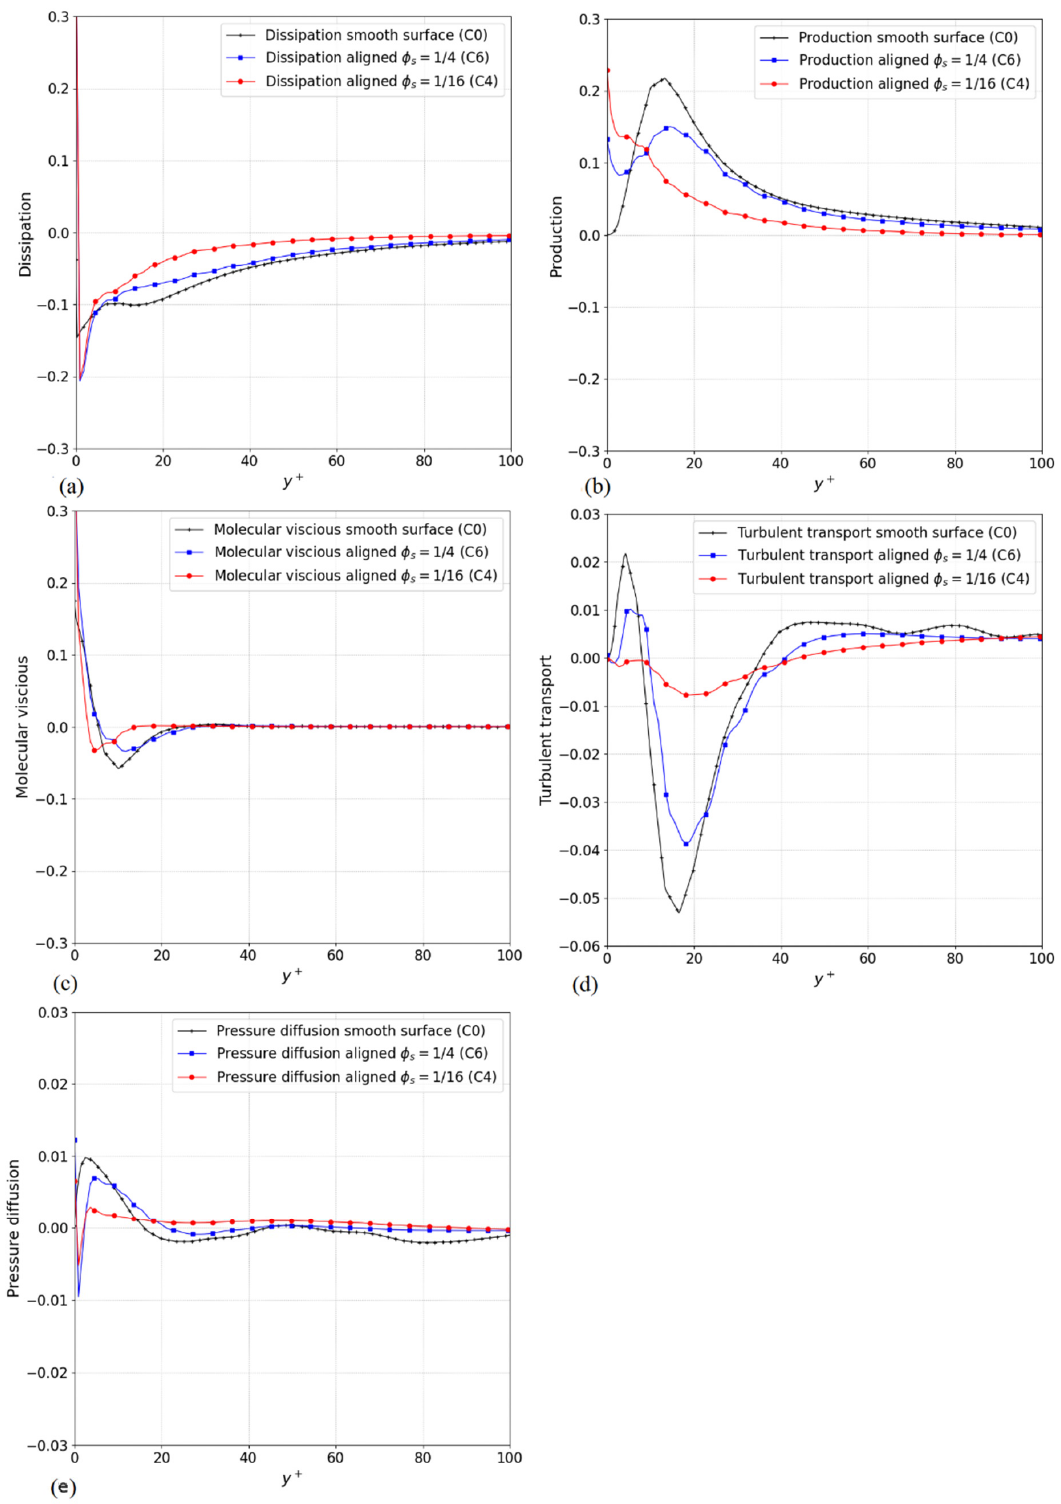
Figure 16. Turbulent kinematic energy budgets of threes case: smooth case, and SHS at φ s = 1 with aligned distributions: ( a ) dissipation, ( b ) production, ( c ) molecular viscous, ( d ) turbulent transport, and ( e ) pressure diffusion.